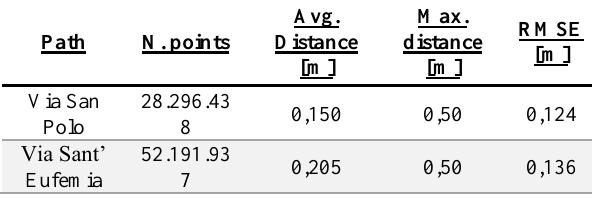
Table 5. Statistical results from the distance comparison between photogrammetry point cloud and the Kaarta Stencil 2 point cloud